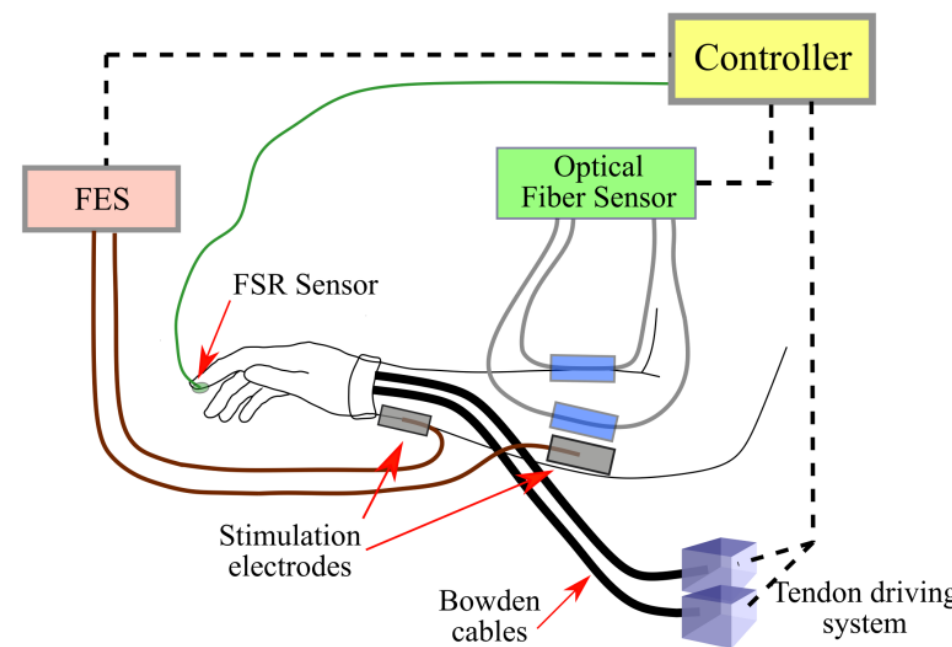
Figure 1. Design of the integrated FMG-driven robotic glove orthosis.